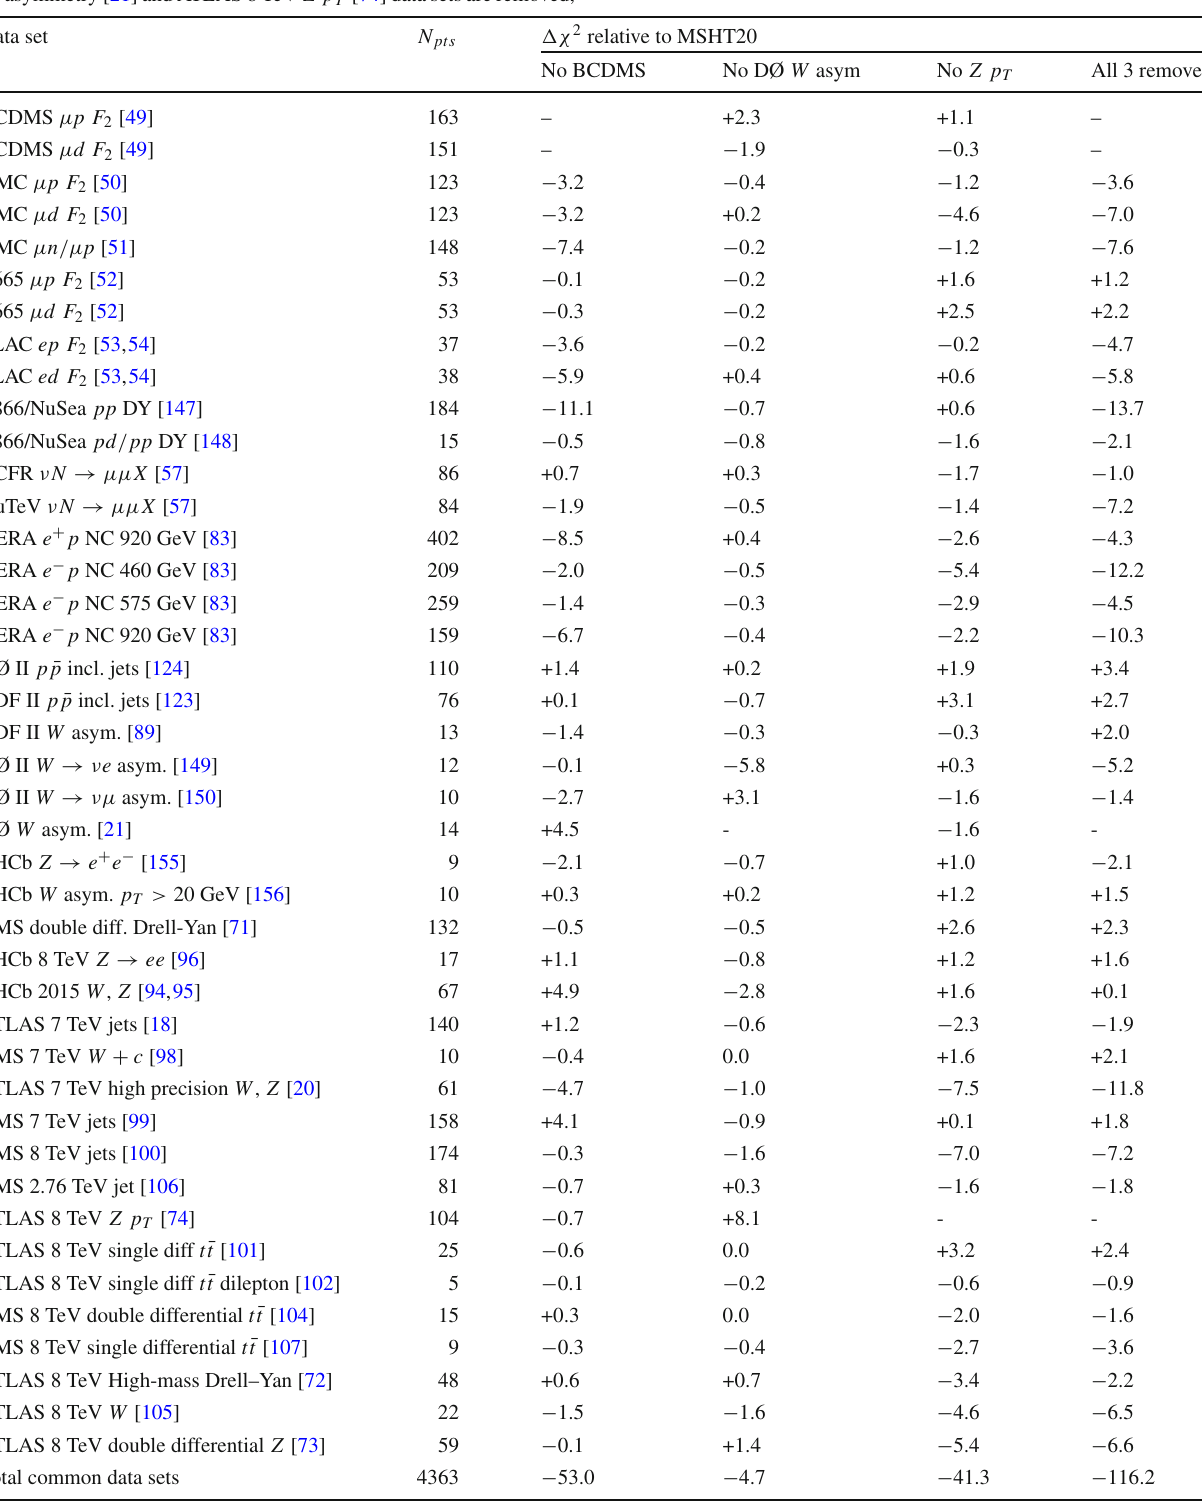
Table 16 The change in χ 2 (with negative indicating an improvement in the fit quality) for a selection of data sets once the BCDMS [49], DØ W asymmetry [21] and ATLAS 8 TeV Z p T [74] data sets are removed,